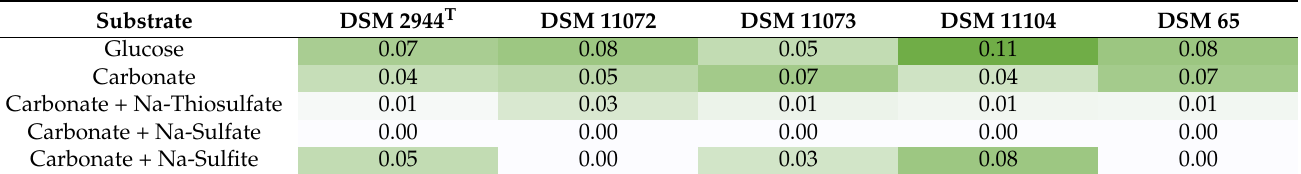
Table 5. Growth on different sulfur compounds. The growth rates in h − 1 during growth on glucose and carbonate as positive and negative controls without any additional electron donor, respectively, were investigated. The ammonium sulfate from an MSM medium was replaced with ammonium chloride. Growth rates were determined by a Growth Profiler experiment, and an automatic algorithm was applied to the data. All values are based on biological triplicates. The standard deviation of every dataset was below 0.005, and is therefore omitted from the